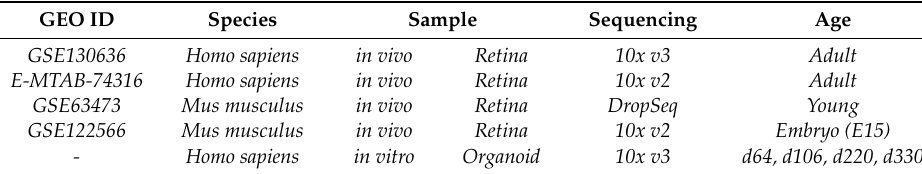
Table 3. Single cell RNA sequencing